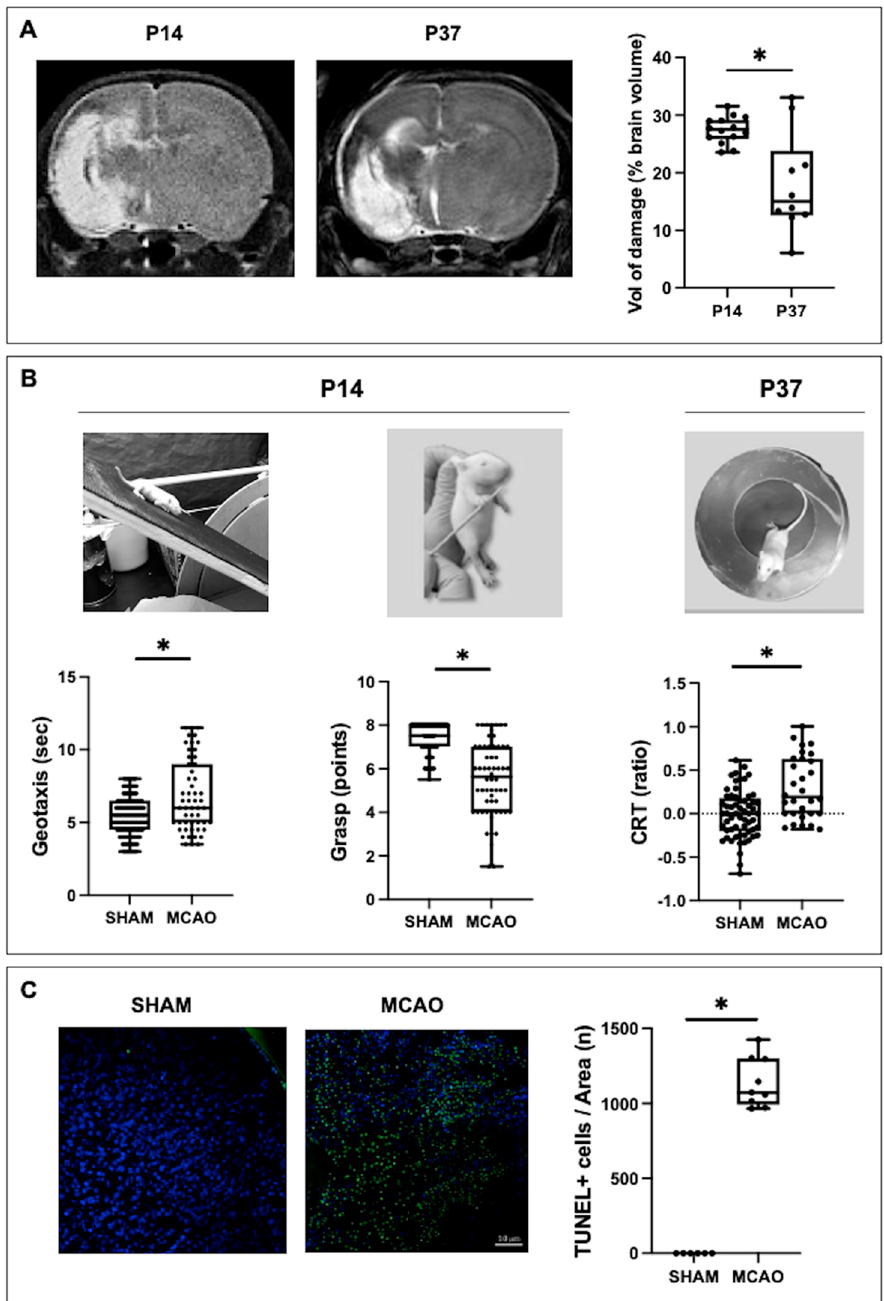
Figure 1. Assessment of brain damage in rats submitted to MCAO at seven days of life (P7) and the corresponding healthy controls (SHAM). ( A ) Representative T2-Weighted MRI scans, and quantification of lesion volume, measured at P14 and P37. ( B ) Functional consequences of MCAO measured in the medium (P14) and long terms (P37). ( C ) Illustrative photomicrographs of TUNEL staining in brain samples obtained at P14 and their quantification. Original magnification: x20. Boxes represent the median and the interquartile range, whereas whiskers represent the minimum and maximum values in each group. CRT: cylinder rear test. (*) p < 0.05 by Mann − Whitney test: ( A ): U = 20, p = 0.18; ( B ): Geotaxis: U = 2516, p = 0.0006; Grasp: U = 1412, p < 0.0001; CRT: U = 480, p = 0.0001; ( C ): U = 0, p = 0.0002.